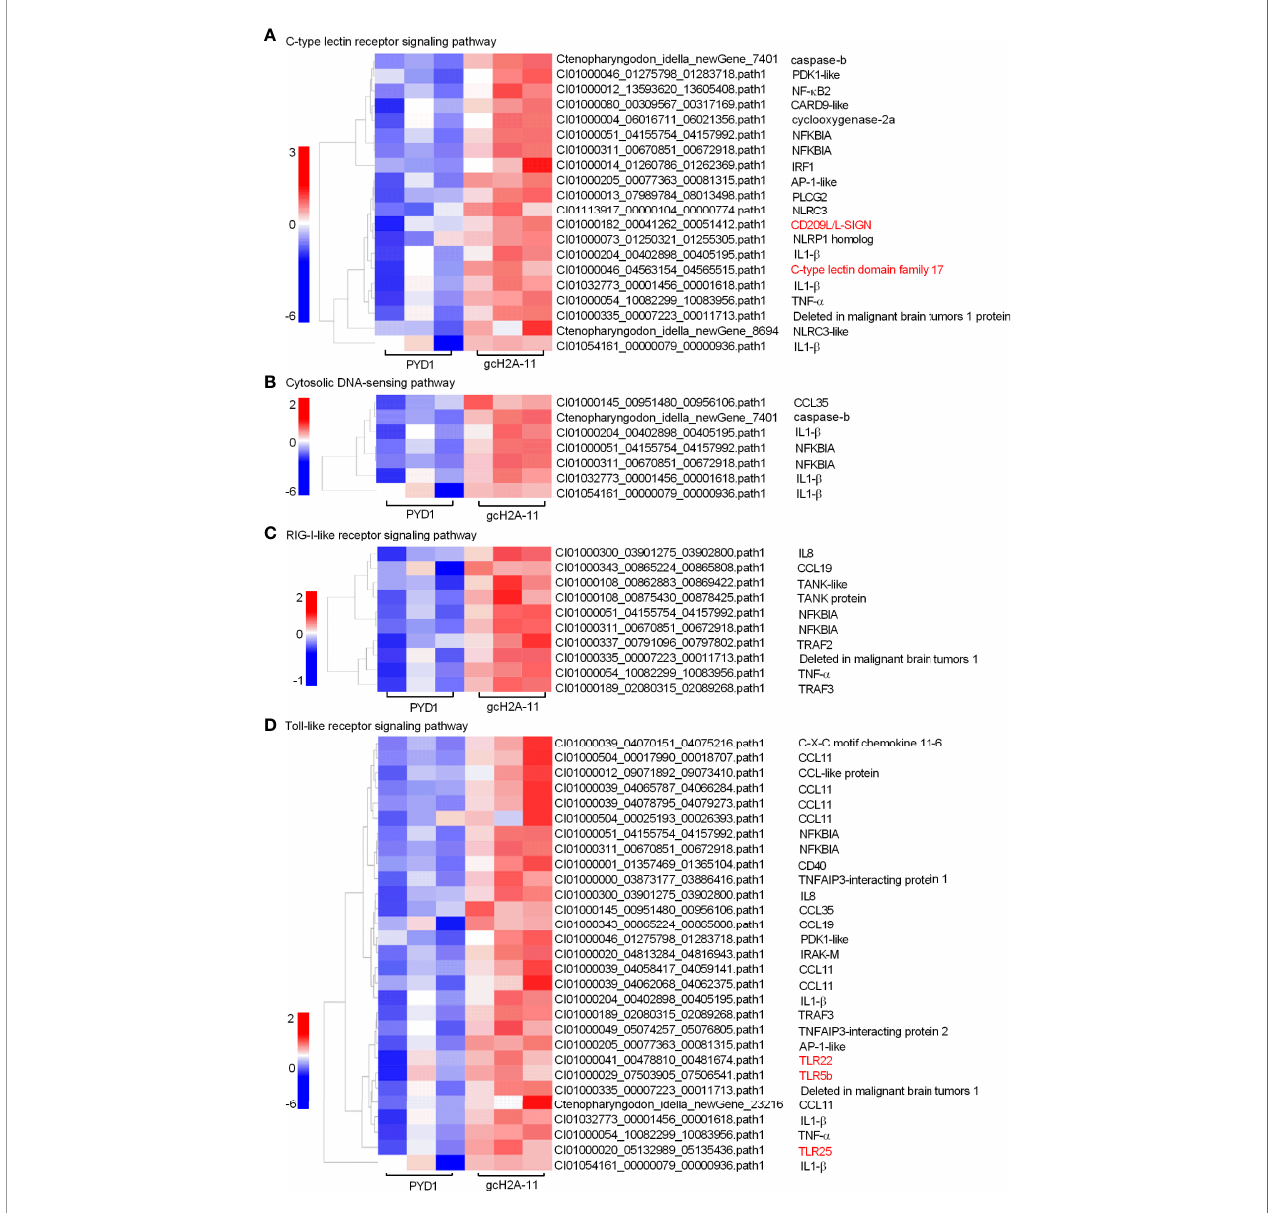
FIGURE 6 | The effects of the engineered S. cerevisiae expressing gcH2A-11 on the expression patterns of DEGs involved in PRRs-mediated signaling pathways. (A) The gene cluster for DEGs involved in the C-type lectin receptor signaling pathway for the samples from the intestines of grass carp after 7 days of the fi rst immunization. (B) The gene cluster for DEGs involved in the Cytosolic DNA-sensing pathway for the samples from the intestines of grass carp after 7 days of the fi rst immunization. (C) The gene cluster for DEGs involved in the RIG-I-like receptor signaling pathway for the samples from the intestines of grass carp after 7 days of the fi rst immunization. (D) The gene cluster for DEGs involved in the Toll-like receptor signaling pathway for the samples from the intestines of grass carp after 7 days of the fi rst immunization. A color key denotes the gradient scale of gene expression from low (blue) to high (red) degrees. The receptors of CLR and TLR are